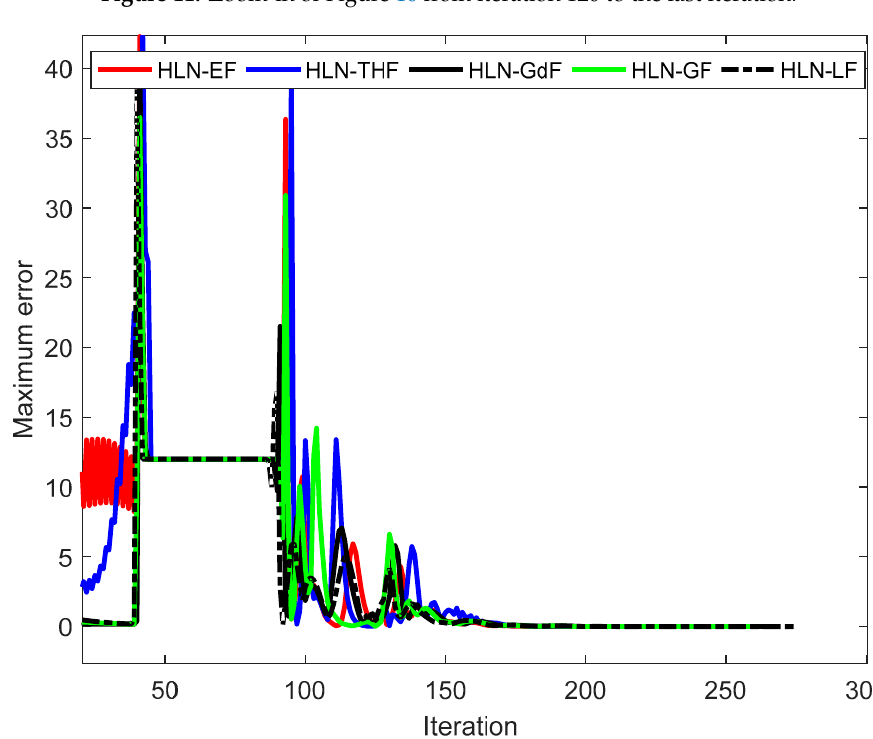
Figure 11. Zoom-in of Figure 10 from iteration 120 to the last iteration.